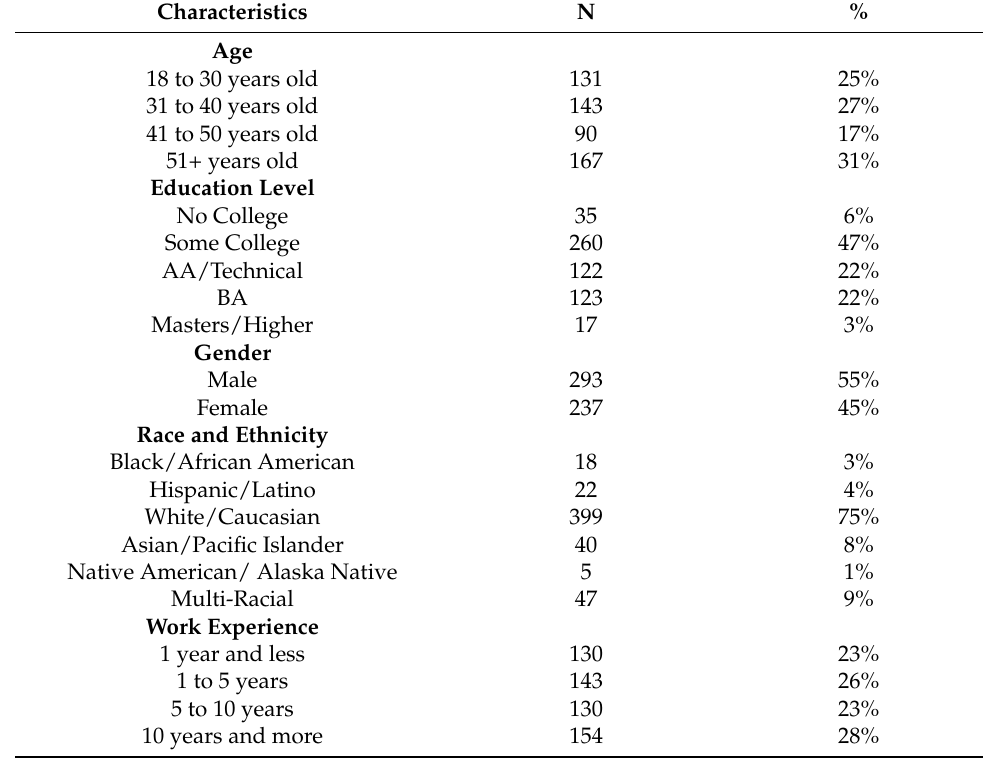
Table 2. Description of the study respondents.